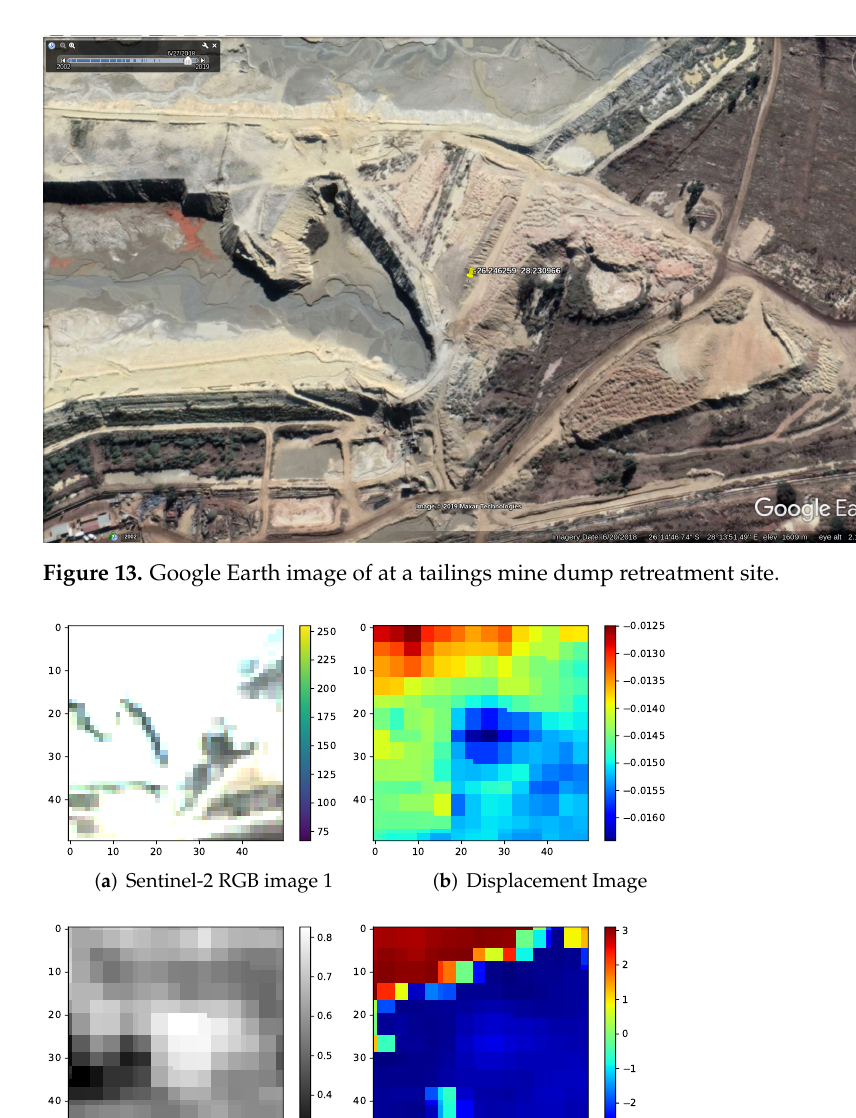
Figure 12. Sentinel-2 images of a true-positive blob at a tailings mine dump retreatment site.